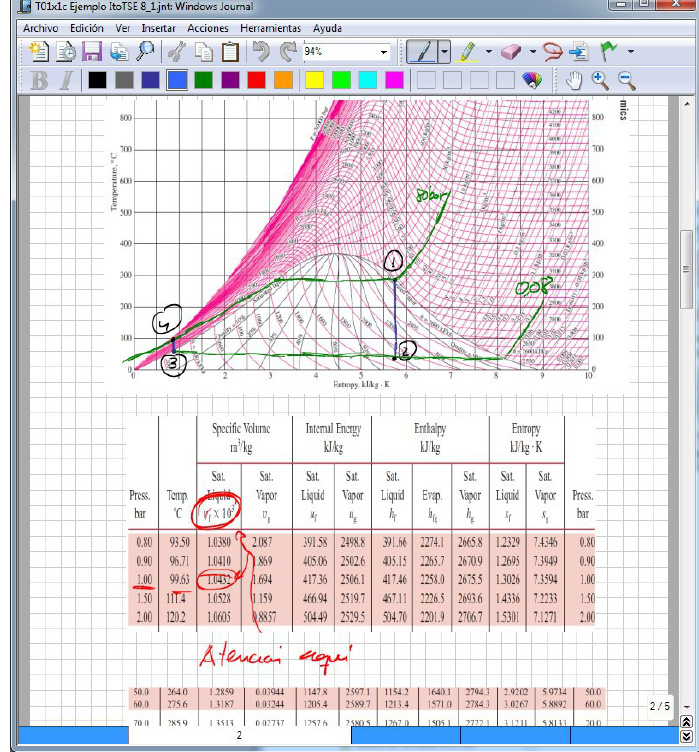
Figure 2. Windows Journal allows to seamlessly combine graphics, tables, and handwritten